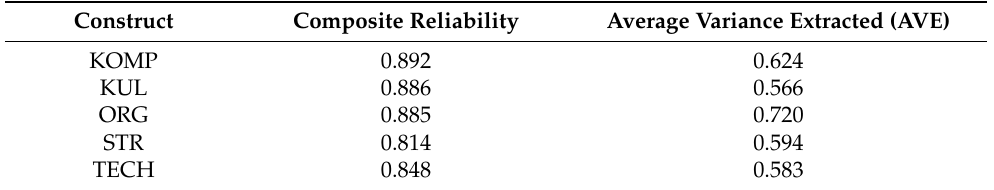
Table 3. Measures of the constructs’ quality in the model.